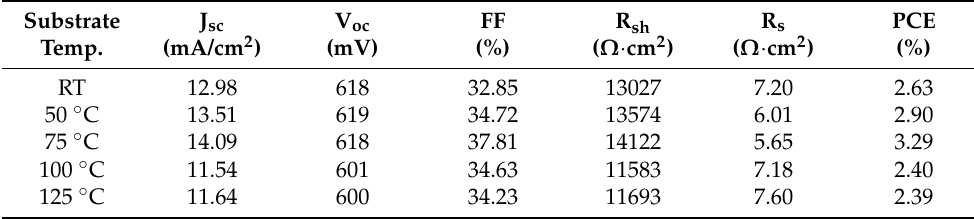
Table 1. Solar cell performance parameters of Si/V 2 O 5 − x HSCs. Substrate